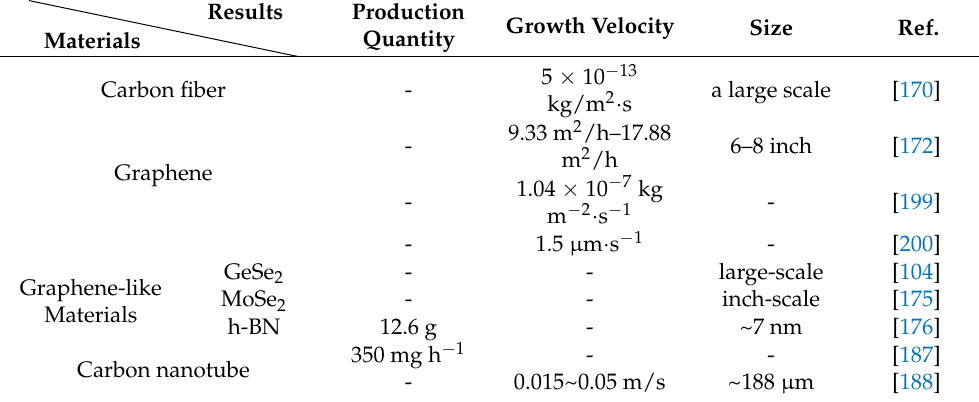
Table 3. Optimization of carbon nanomaterials properties and synthesis parameters by using com- puter